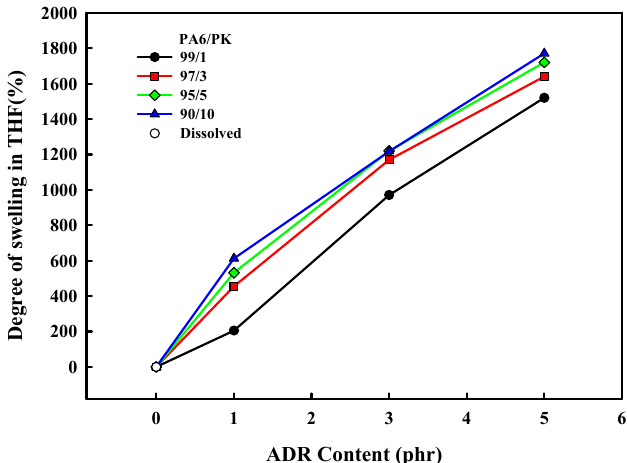
Figure 6. Effect of chain extender, ADR content on the degree of swelling of PA6/PK blends swollen in THF at 50°C for 100 min.